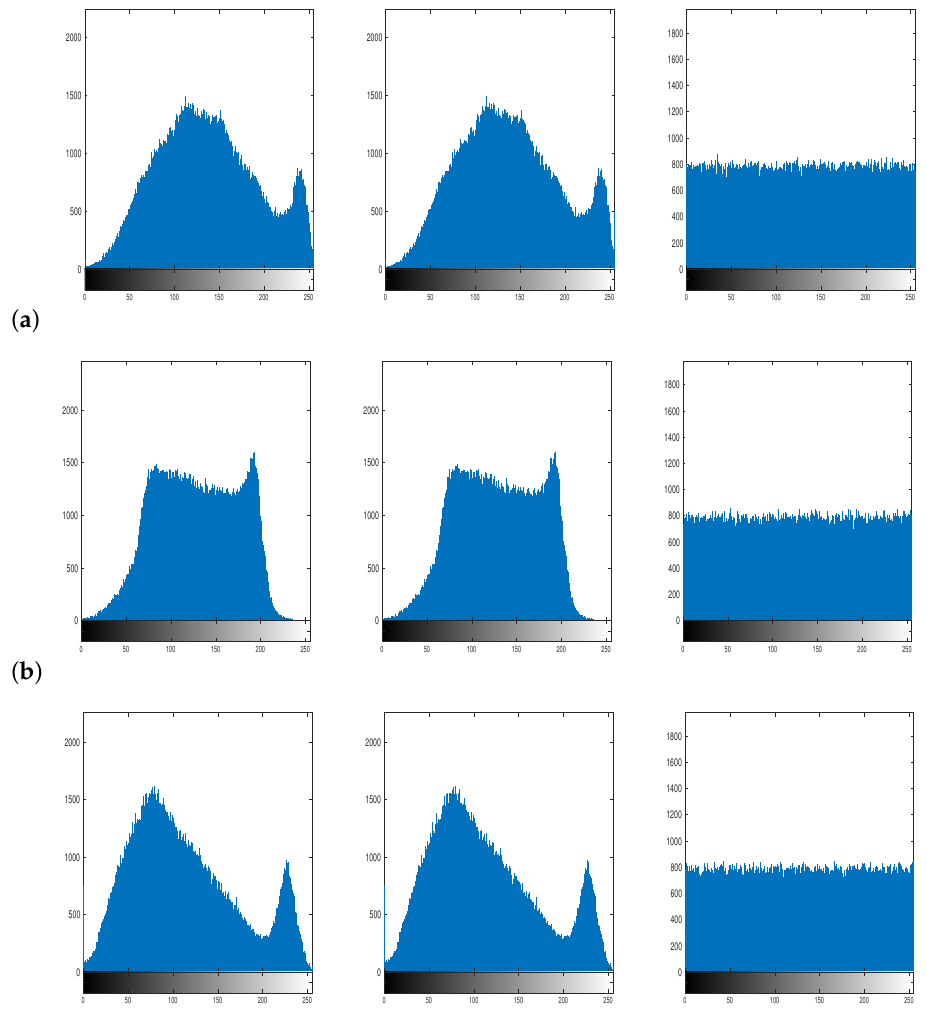
Figure 18. Histograms for ( a ) red, ( b ) green, and ( c ) blue color components of Baboon image for plain, shuffled, and cipher images, in left, middle, and right columns, respectively. The x-axis represents the pixel values of the image for the red color component (in ( a )), green color component (in ( b )), and blue color component (in ( c )). The y-axis represents the number of occurrences of different pixel values in the